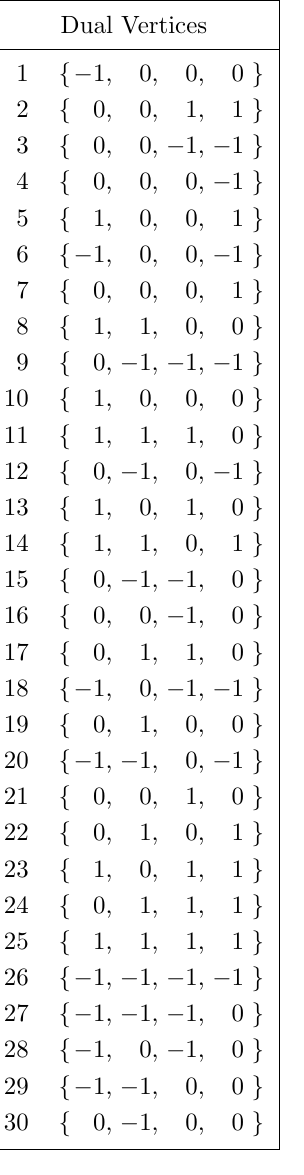
Table 13 . The data for the dual polyhedron, r